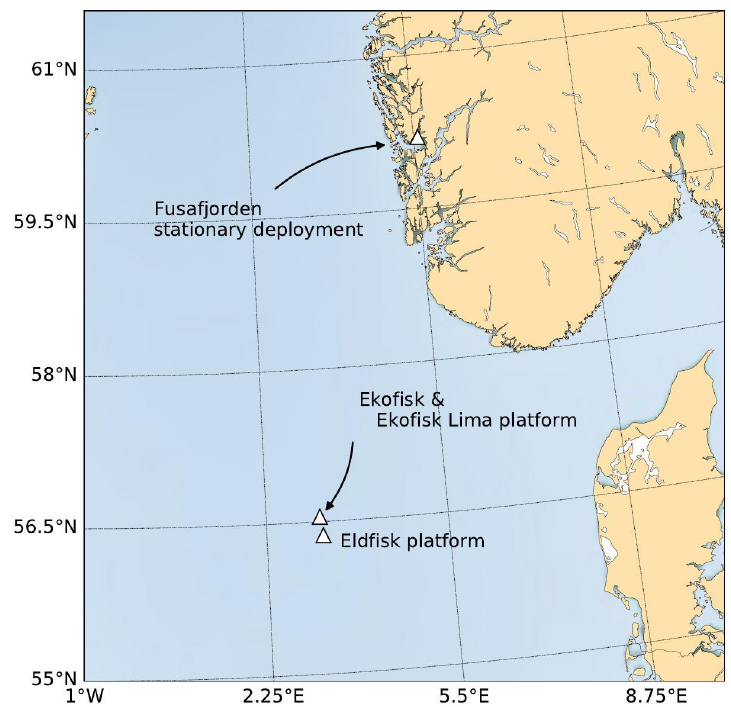
Figure 1. Map of the central North Sea with marked locations where the validation campaigns took place: the stationary deployment in Fusafjorden and the undersail deployment near the Ekofisk and Eldfisk oil and gas platforms. Table 1. Overview and instrument specifications of the different current measurement devices used in this study. ADCPs are profiling instruments, while the DCS (Doppler current sensor) is a point meter. The two numbers of pings per sampling interval given for the SB ADCP correspond to the Fusafjorden and the Ekofisk campaign,